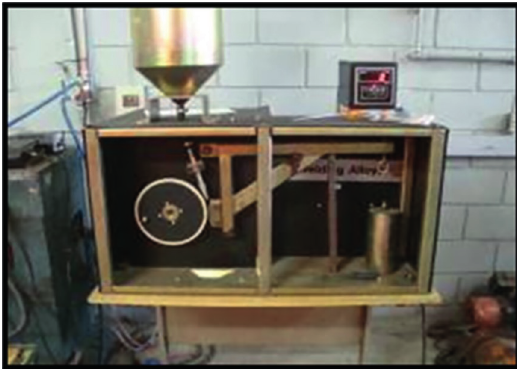
Figure 3: Rubber wheel abrasion resistance machine used to simulating the low stress abrasion.